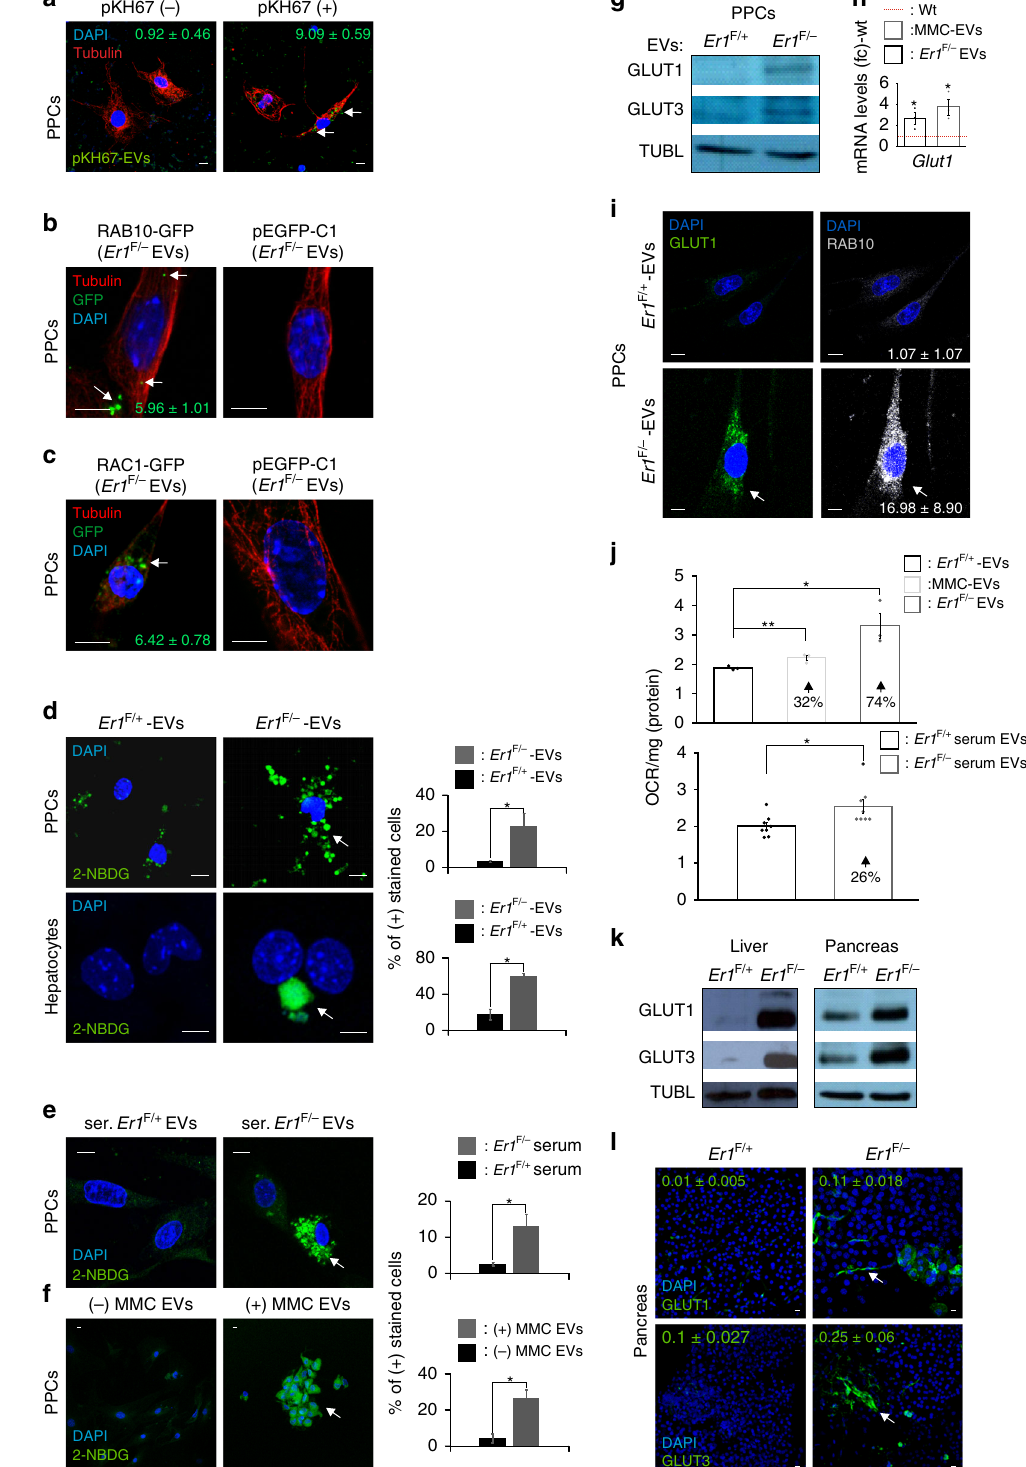
fed either a high-fat diet (60% energy from fat, 20.3% carbohydrate, and 18.41% protein, 58Y1-58126, TestDiet) or a normal diet (Lactamin, Stockholm, Sweden). Mice had access to water ad libitum. Body weight was measured weekly. For food intake experiments, mice were kept individually in separate cages. De fi ned food quantity was added daily in each cage and food consumption was measured every 24 h. This work received ethical approval by and independent Animal Ethical Committee at the IMBB-FORTH. All relevant ethical guidelines for the work with animals were adhered to during this study. For the in vivo 2-DG uptake assay 6- months old male mice were used (three in each group). Animals were fasted